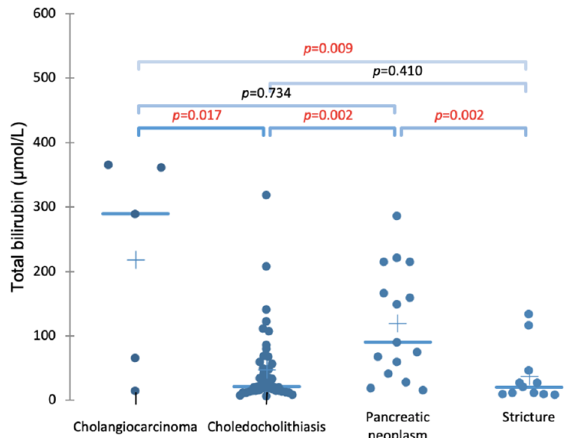
Figure 1. Comparison of the bilirubin levels in the serum of patients with different conditions resulting in biliary blockage. It can clearly be seen that the bilirubin levels in the case of a neoplasm (either cholangiocarcinoma or pancreatic) is significantly higher compared to benign strictures or choledocholithiasis. p-values were determined using the Kruskal-Wallis test with the Dunn post hoc nonparametic comparison.